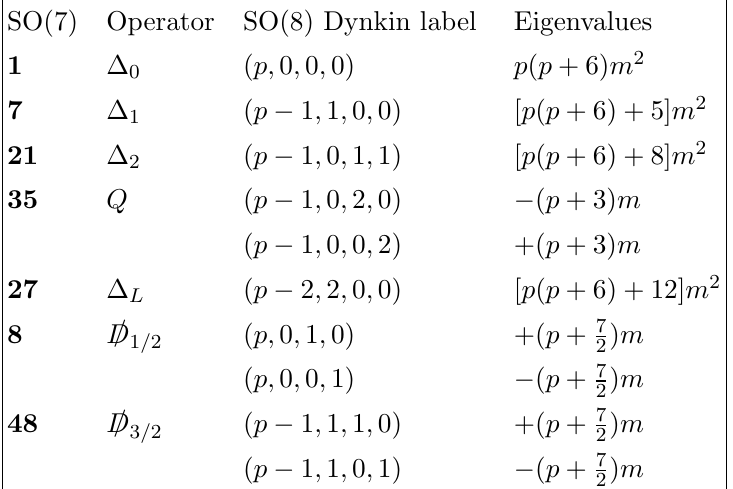
Table 3. The round S 7 eigenvalues of the differential operators acting on SO(8) harmonics. The SO(7) representations are given in terms of their dimension.